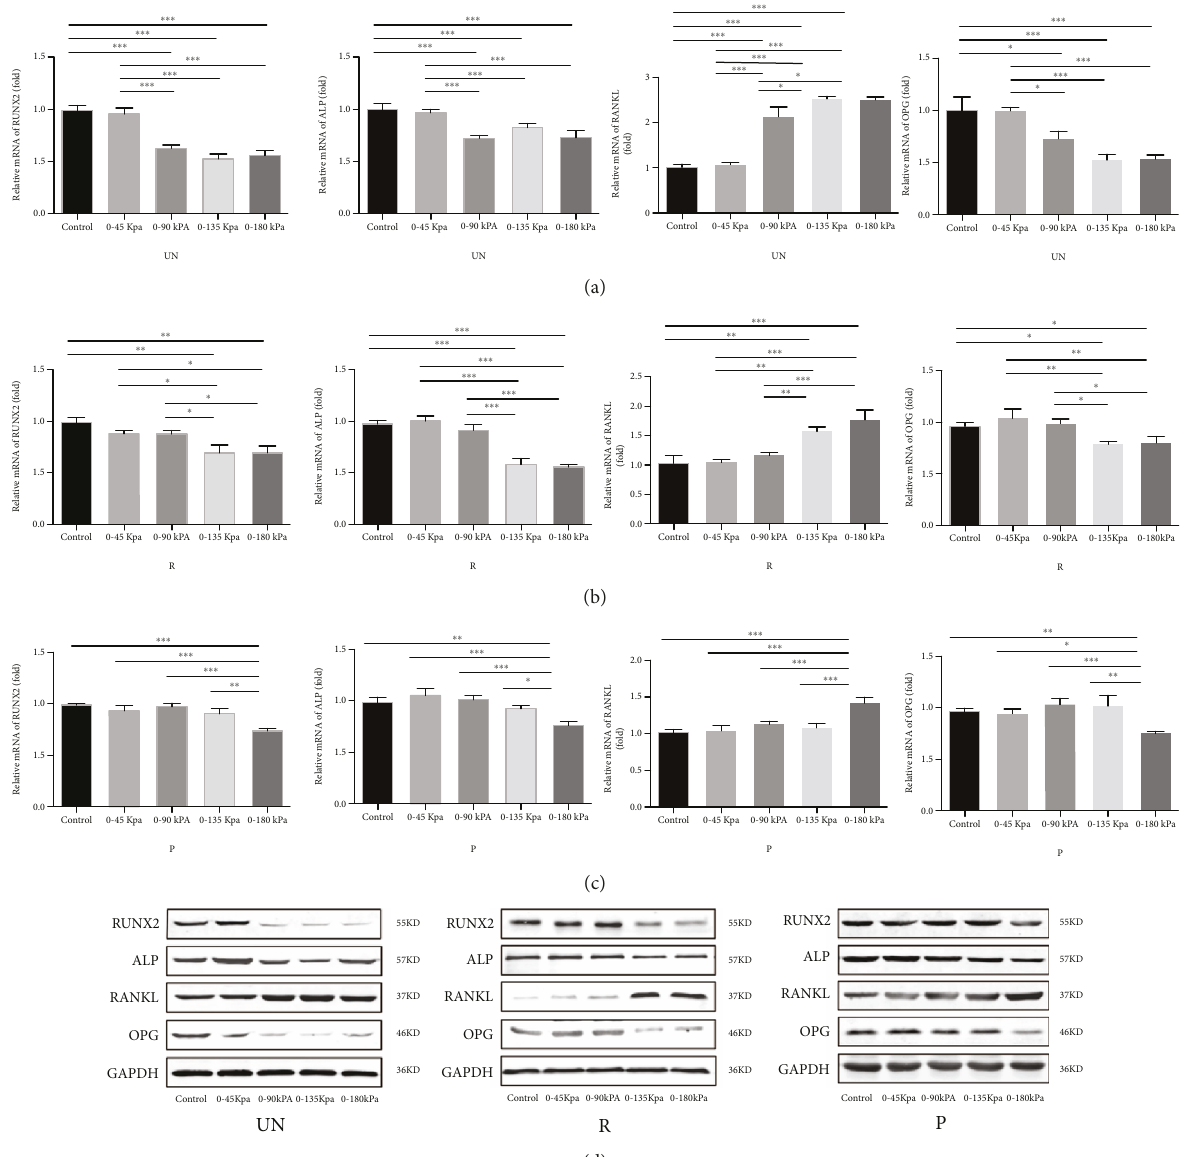
Figure 2: E ff ects of mechanical pressure on the osteogenic and the osteoclastic di ff erentiation in PDLSCs. (a – c) qRT-PCR was performed to assess RUNX2 , ALP , RANKL , and OPG expression levels in di ff erent groups. Values are reported as mean ± SD ( ∗ P ≤ 0 05 , ∗∗ P ≤ 0 01 , and ∗∗∗ P ≤ 0 001 ; one-way ANOVA). (d) The expression levels of RUNX2, ALP, RANKL, and OPG in PDLSCs from each group were examined via Western blot assays. The cyclic hydraulic pressure was performed with a fi xed frequency of 0.1Hz at di ff erent ranges for 2 hours/day for three consecutive